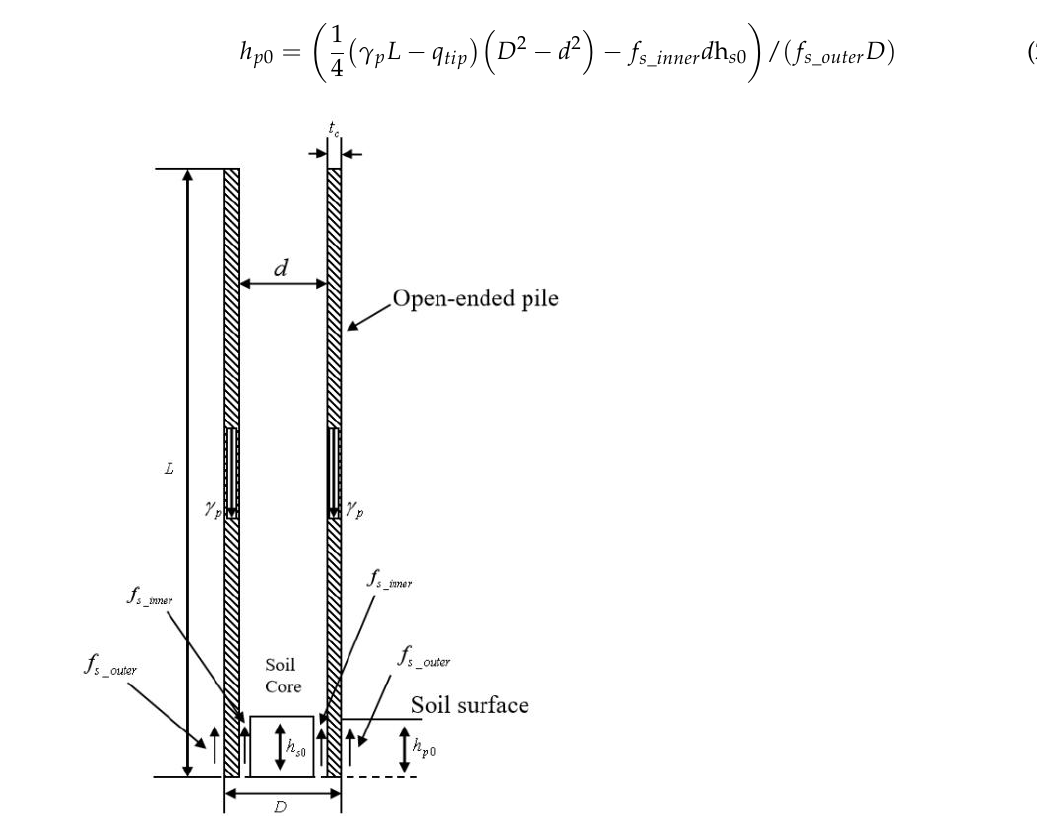
Figure 1. Schematic diagram of self-sinking force equilibrium of an open pile.